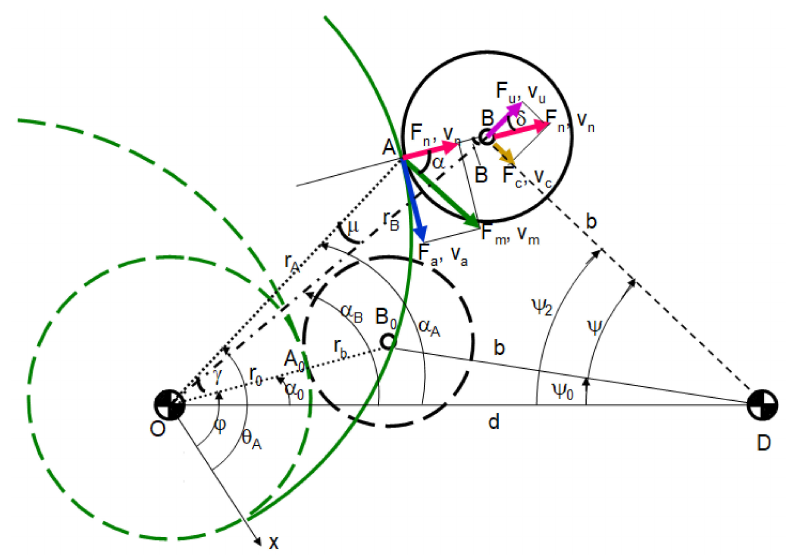
Figure 7. Forces and velocities to a mechanism with rotating cam and rotating adept with